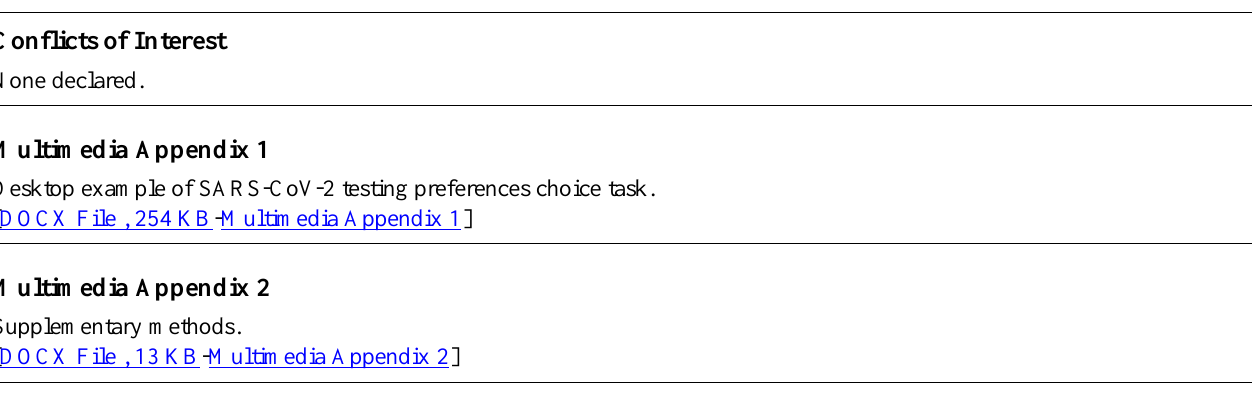
Table S1 (average relative attribute importance for SARS-CoV-2 testing features) and Table S2 (part-worth utilities for SARS-CoV-2 testing